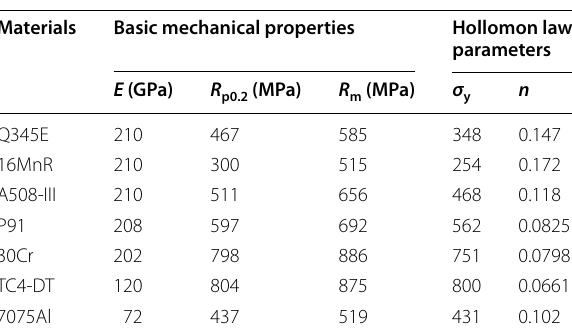
Table 4 Basic mechanical properties and Hollomon